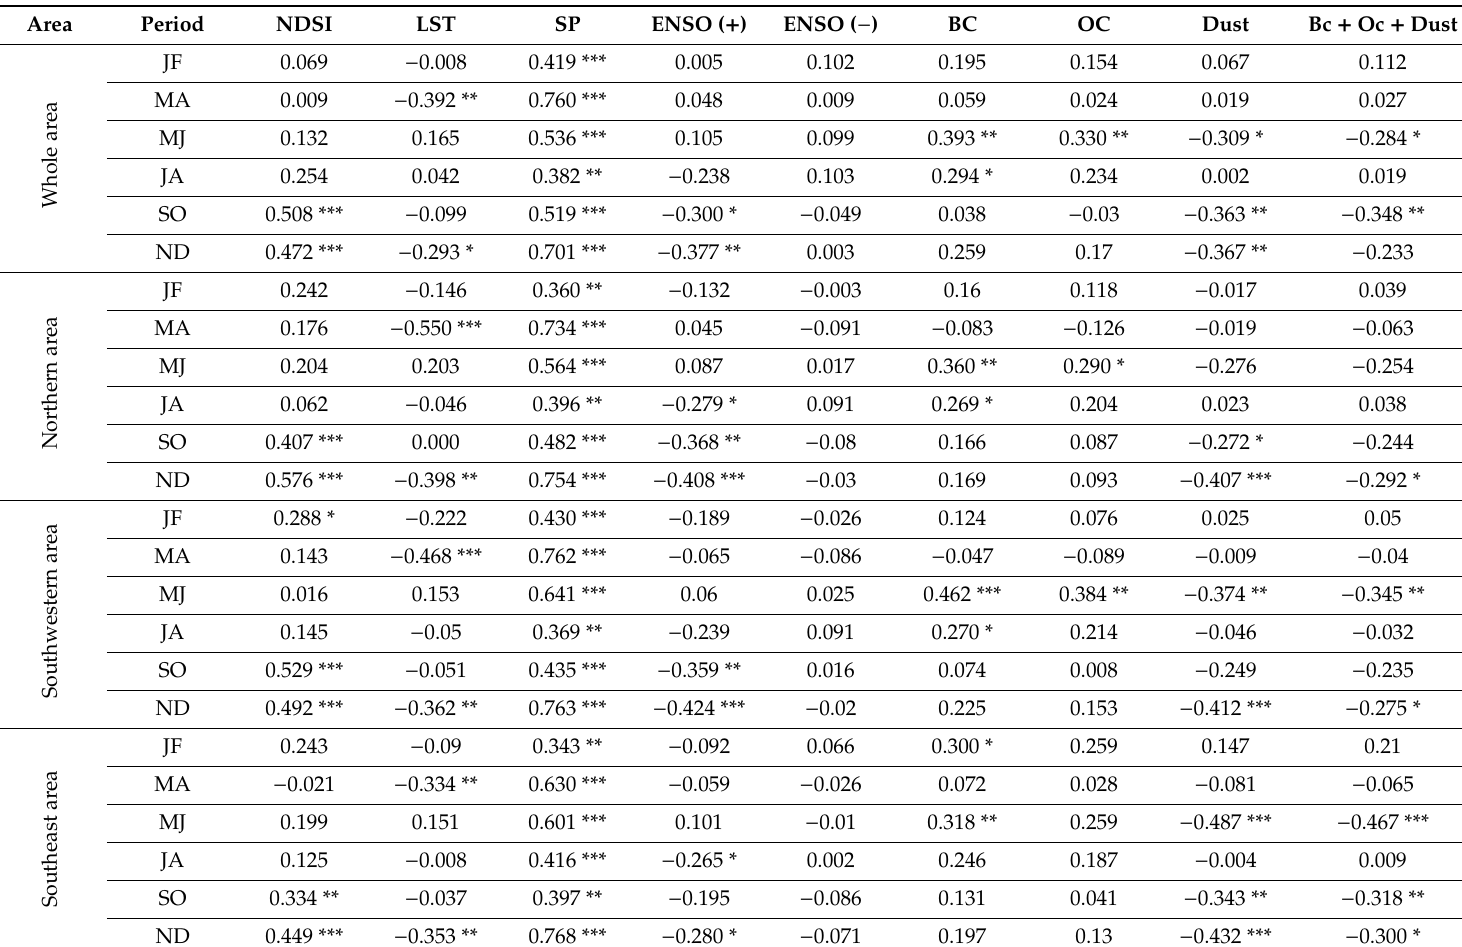
Table 2. Empirical results of the Pearson correlation coe ffi cient (r) between snow albedo and the variables analyzed. Where *, ** and *** denote significant correlations at p < 0.05, p < 0.01, and p < 0.001,